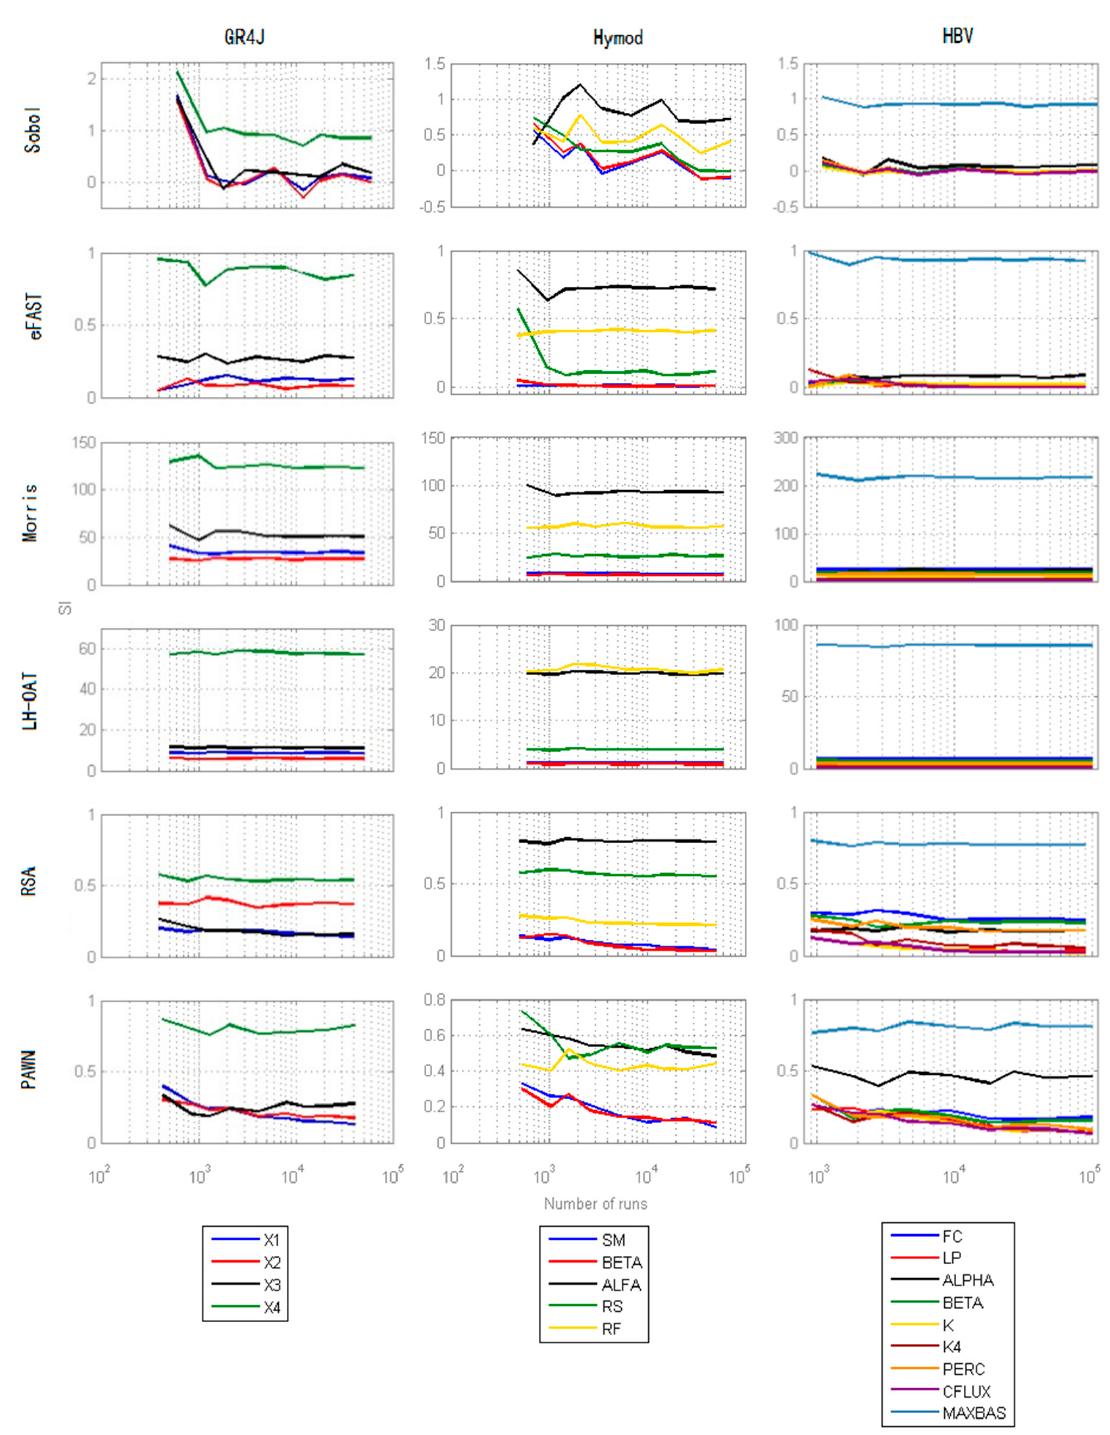
Figure 11. Sensitivity Indices of different Sensitivity Analysis (SA) methods with different number of runs for GR4J ( left column ), Hymod ( mid column ), and HBV ( right column ) model, the horizontal axis is in log scale.